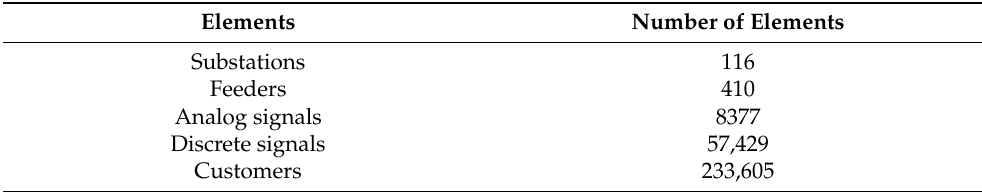
Table 2. Distribution network.